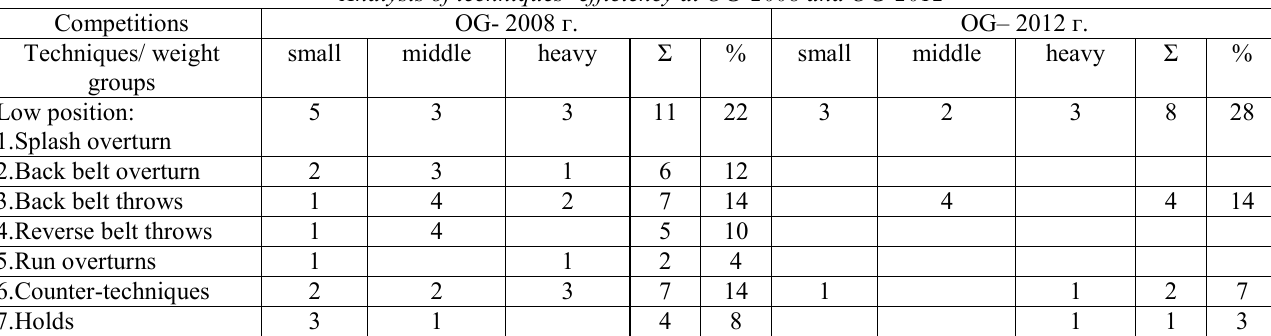
Analysis of techniques’ efficiency at OG-2008 and OG-2012 OG- 2008 г. OG– 2012